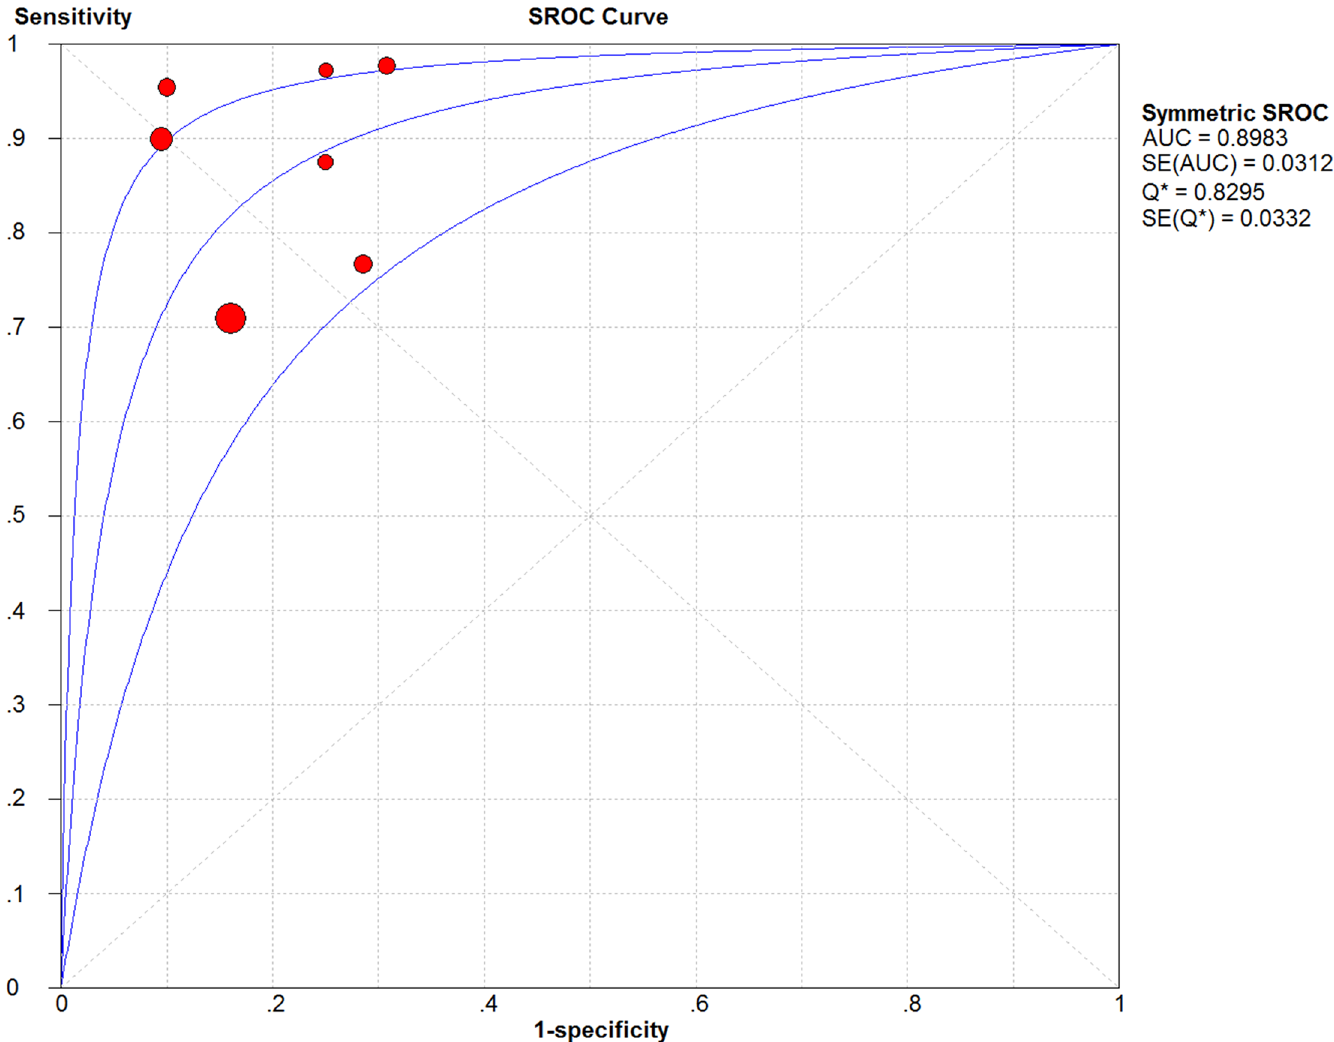
Fig 4. Summary Receiving Operating Characteristic Curve (SROC) Plot. The SROC and its 95% confidence interval (CI) boundaries are represented by the three blue lines. Each of the included studies is represented by a red circle with the weight of each study depicted by the size of its respective circle. The area under the curve (AUC) was calculated by numerical integration of the